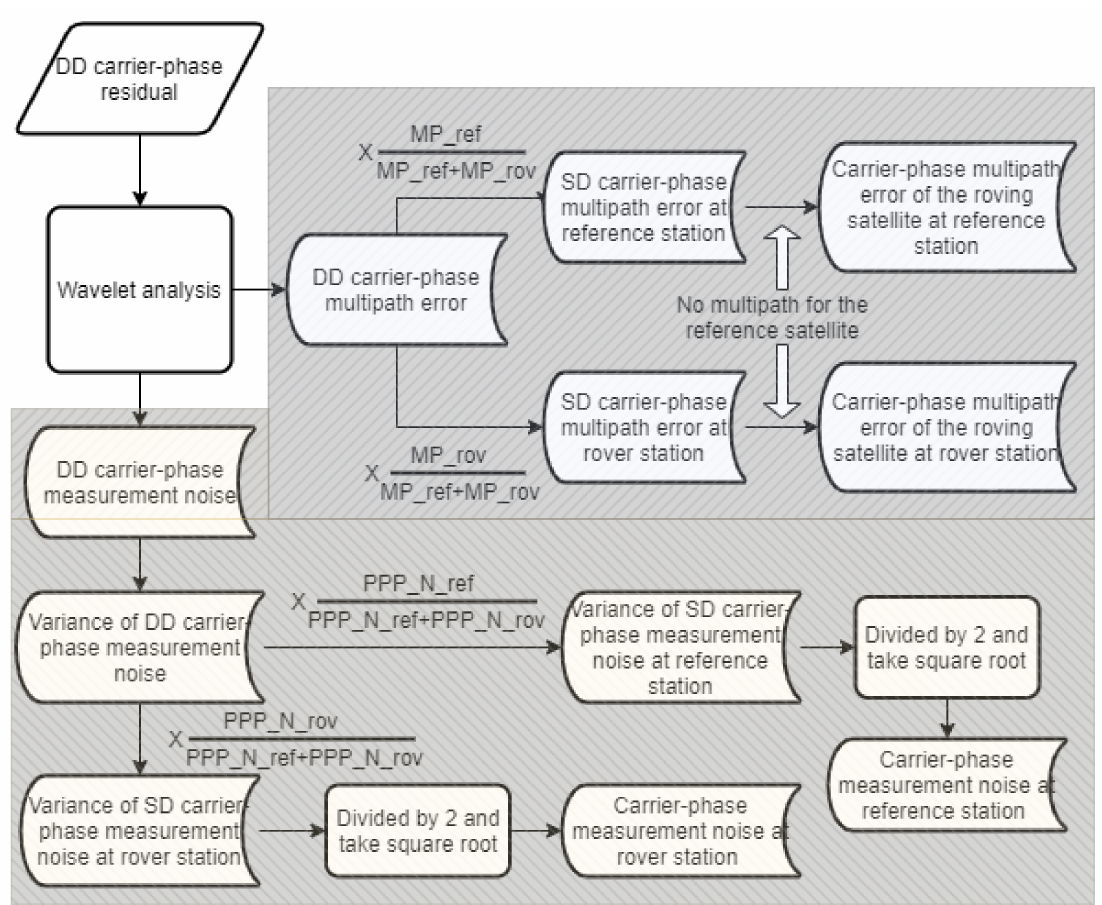
Figure 2. The process for obtaining the carrier-phase multipath error and measurement noise at an epoch. MP_ref and MP_rov denote the pseudorange multipath errors at the reference and rover stations, respectively. PPP_N_ref and PPP_N_rov denote the PPP-determined noise levels at the reference and rover CORS stations,